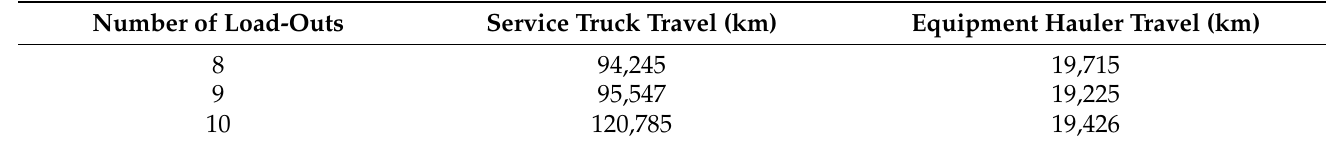
Table 5. Total service truck and equipment hauler travels for the three load-out simulations.